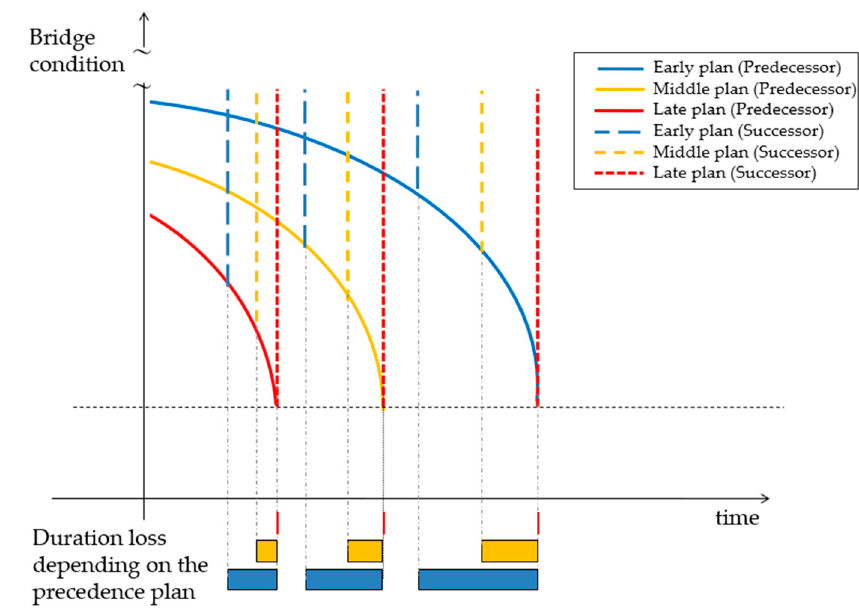
Figure 4. Impact of subsequent plans on different leading programs.